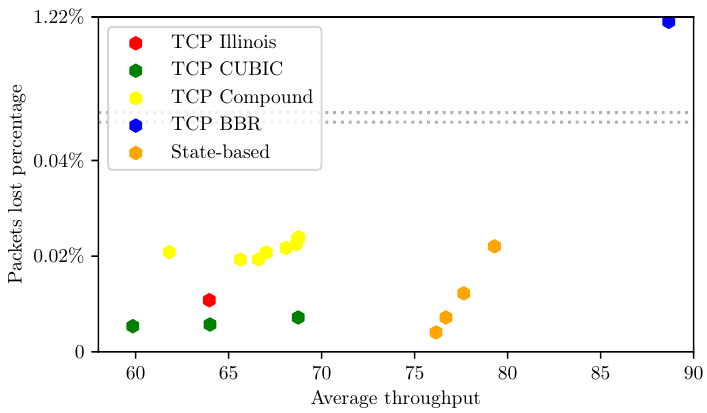
Figure 8. Performance of TCP control